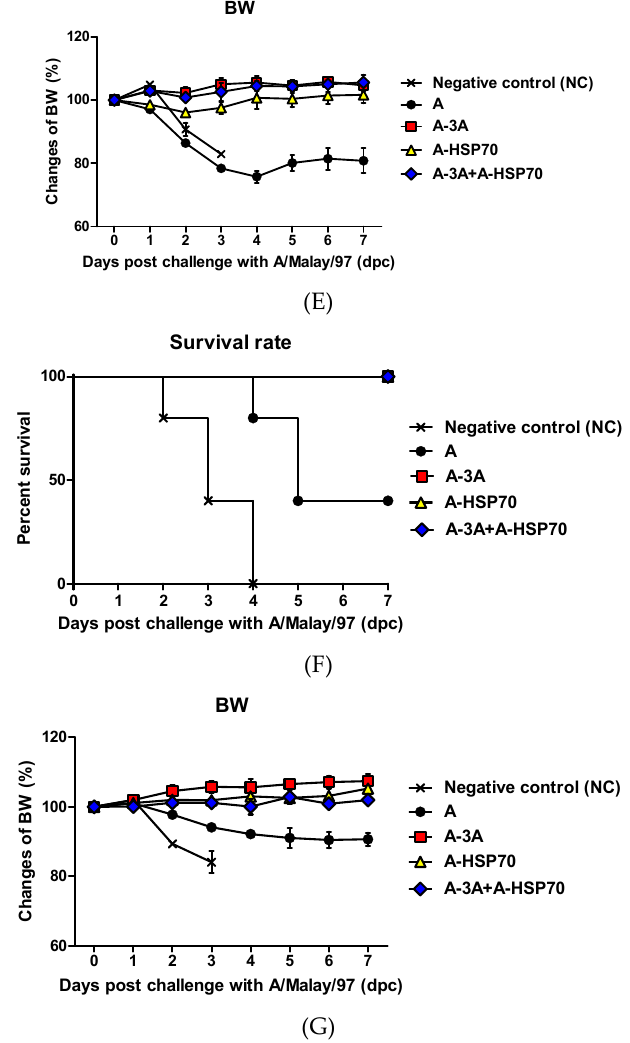
Figure 3. A-3A and A-HSP70 mediated a long-lasting memory response in mice. C57BL/6 mice were administered with oil emulsion-free test vaccines, including A-3A antigen alone, A-HSP70 antigen alone, or combined A-3A and A-HSP70 antigens based on their positive control composition. The negative control group received PBS in the same volume as the vaccine. A positive control group received 1.5 µ g (1 / 10 dose for cattle and pig use) of naïve A antigen, without ( w / o ) oil emulsion, 10% Al(OH) 3 , and 15 µ g Quil-A. Briefly, vaccination was performed twice at a 35-day interval. The mice were vaccinated intramuscularly in the thigh muscle. Later, at 84 dpv or 168 dpv, the mice were challenged with FMDV (100 LD 50 A/Malay-97, SEA topotype) by intraperitoneal injection. Survival rates and body weights were monitored for 7 dpc. In addition, serum sampled from mice at 0, 7, 14, 28, 56, 84, and 168 dpv was analyzed via SP A ELISA and VN assay. ( A – G ) represent: ( A ) the strategy for this study; ( B ) antibody titers by SP A ELISA; ( C ) VN titers; ( D ) survival rate at 84 dpv challenge; ( E ) changes of body weight at 84 dpv challenge; ( F ) survival rate at 168 dpv challenge; ( G ) changes of body weight at 168 dpv challenge. The data represent the means ± SEM of triplicate measurements ( n = 5/group). Statistical analyses were performed using two-way ANOVA with Bonferroni correction and a one-way ANOVA followed by a Tukey’s post-hoc test. * p < 0.05; ** p < 0.01; *** p < 0.001; ns, not significant. Statistical analyses are summarized in Table S3.